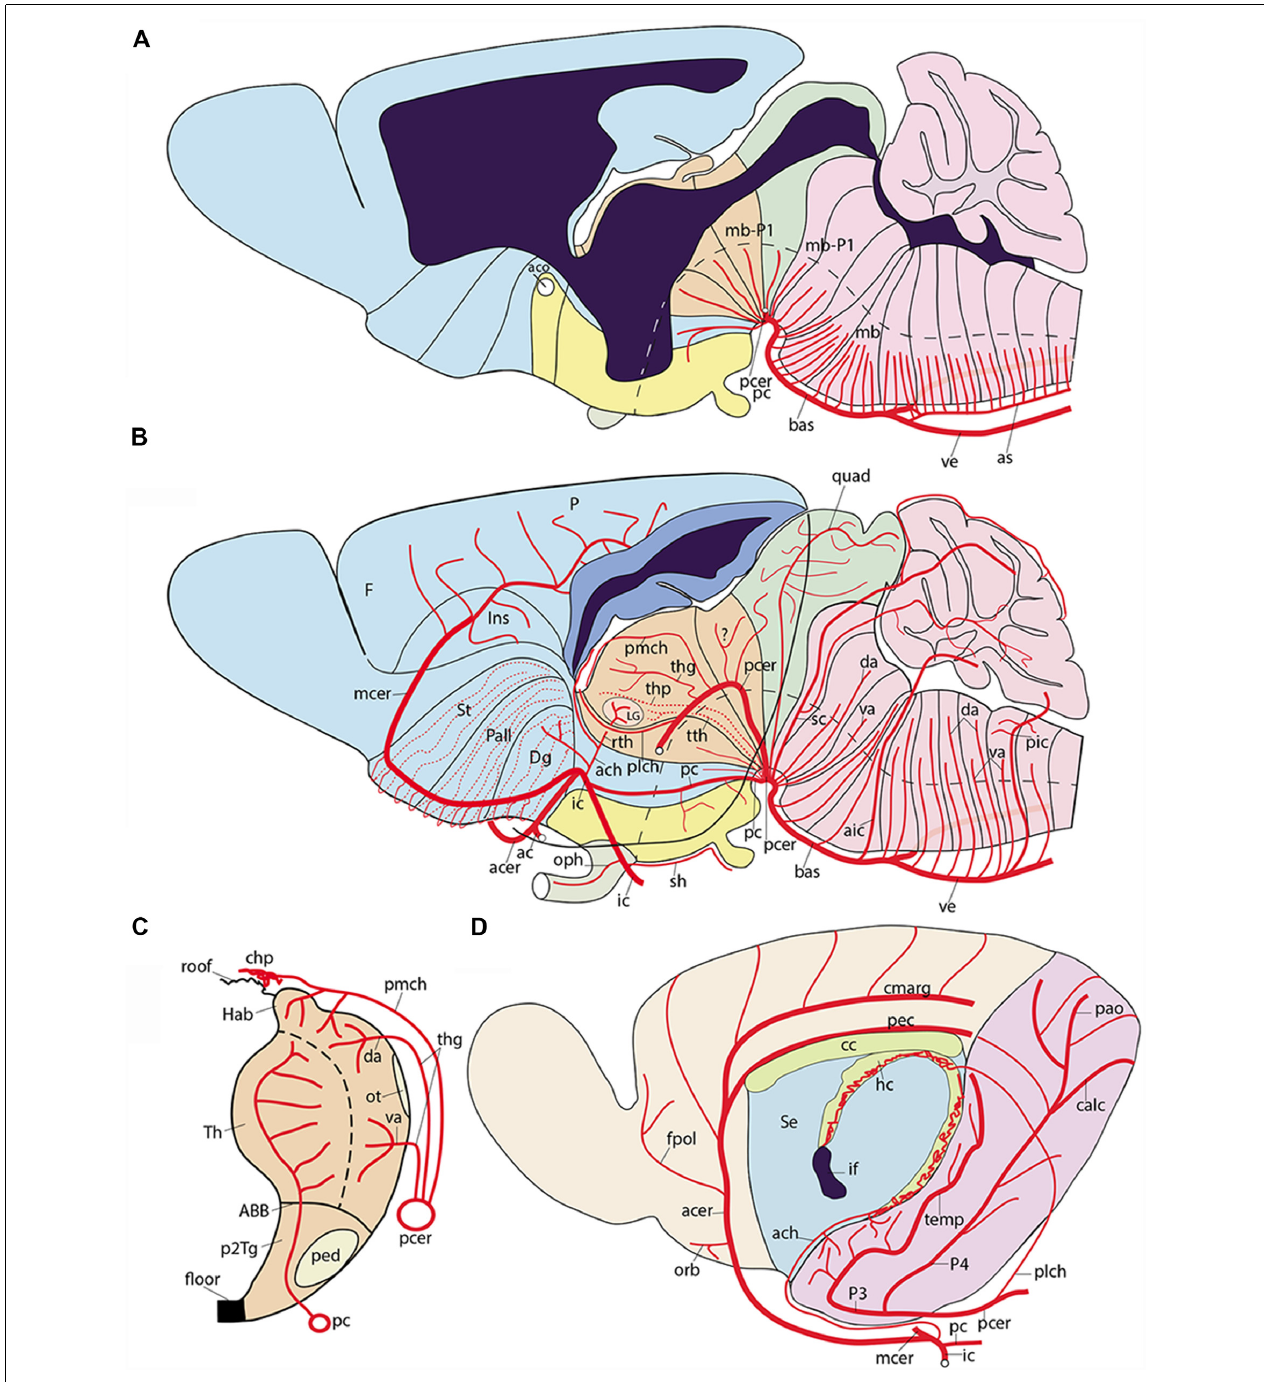
FIGURE 8 | Semi-realistic schemata based on the updated prosomeric model shown in Figure 1A , illustrating the forebrain and hindbrain regions (A,B) , a thalamus cross-section (C) , and the isolated telencephalon (D) , cut in various ways to visualize vascular patterns relative to brain histogenetic units contemplated in the model (transversal neuromeres and dorsoventral alar/basal longitudinal zones). Note the color code of the different brain regions in (A,B) coincides with that in Figure 1A . (A) Schematic paramedian sagittal section (ventricular cavity in black), showing the origins, penetration sites and intraneural topologically transverse course of a continuous set of medial vessels serving the paramedian basal plate all the way into the hypothalamus; these fan out in the forebrain due to the axial incurvation at the cephalic flexure (note similarly bent alar-basal boundary drawn in as a longitudinal black dash line). The basal plate arteries sprout sequentially from the anterior spinal and vertebral arteries (as, ve), the basilar artery (bas), the stem of the posterior cerebral artery (pcer), and the posterior communicating artery (pc); this last artery is not shown, since it lies lateral to this nearly median plane of section). (B) Schema aiming to depict typical courses of arteries